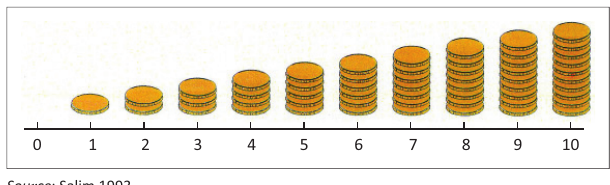
FIGURE 2-A1: The Pakistani Coin Heap Scale.